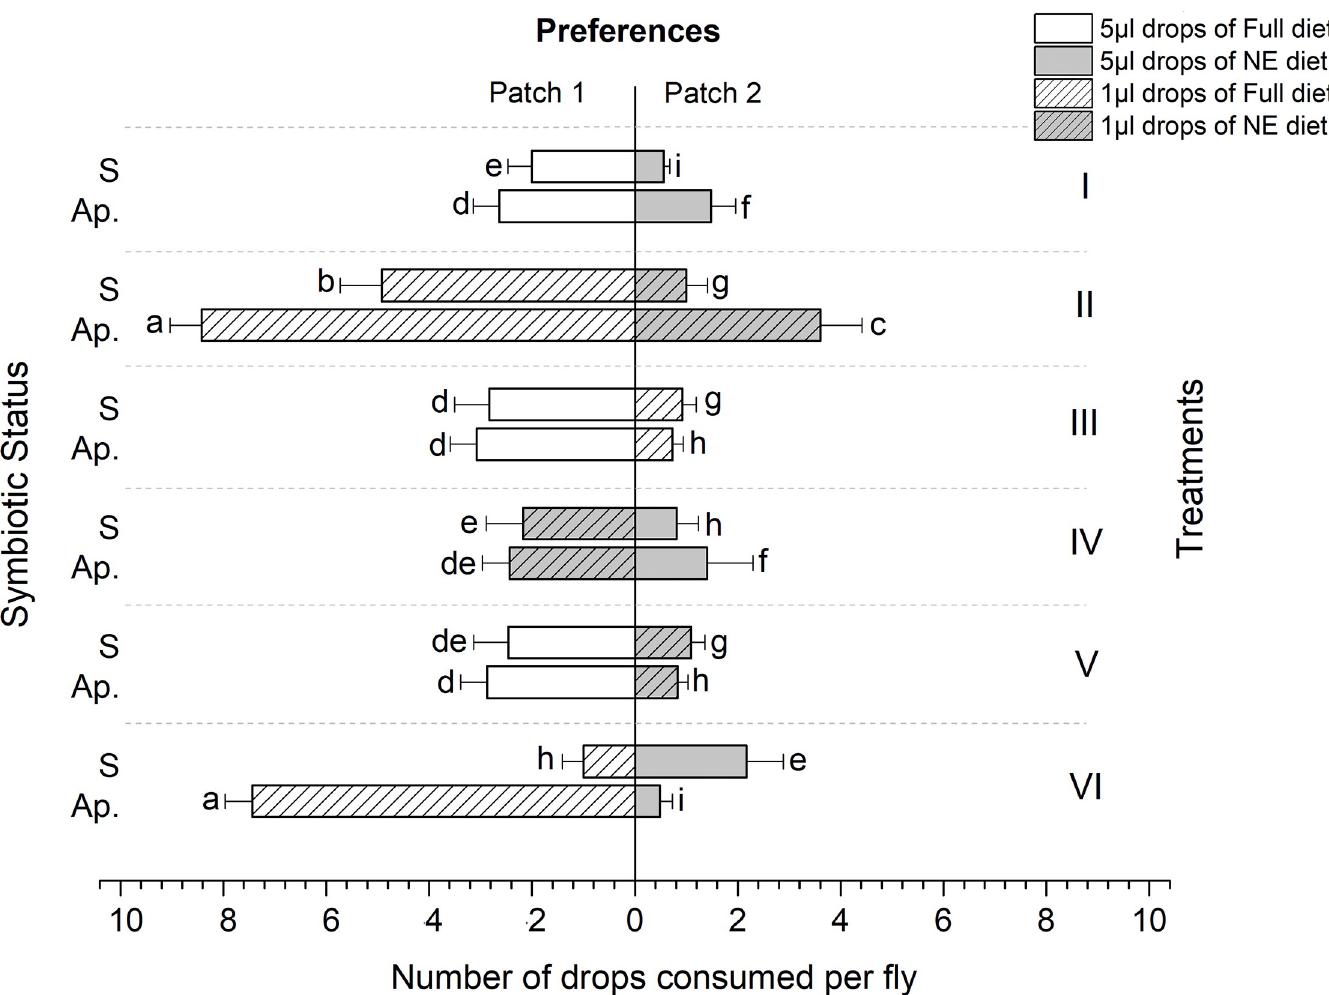
Fig 4. Number of nutritional drops consumed by symbiotic (S) and aposymbiotic (Ap.) Bactrocera dorsalis females exposed to two diet patches (full and non- essential amino acids’ diets). Each bar represents the Mean ± SE of consumed drops by each fly.